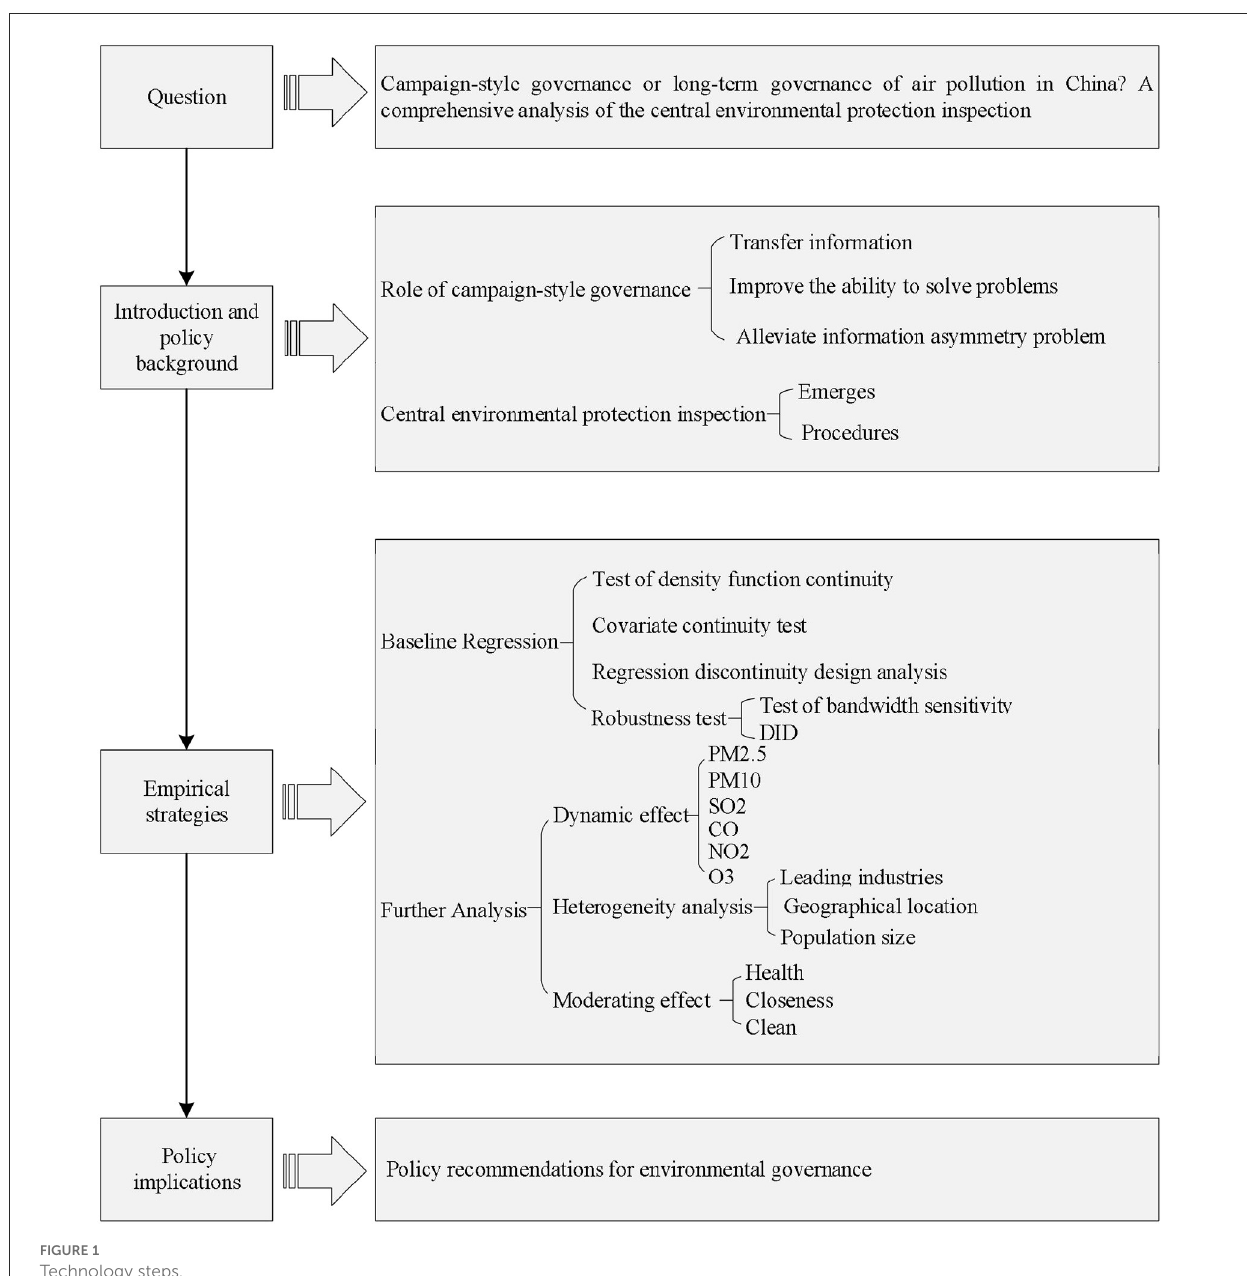
FIGURE1 Technology